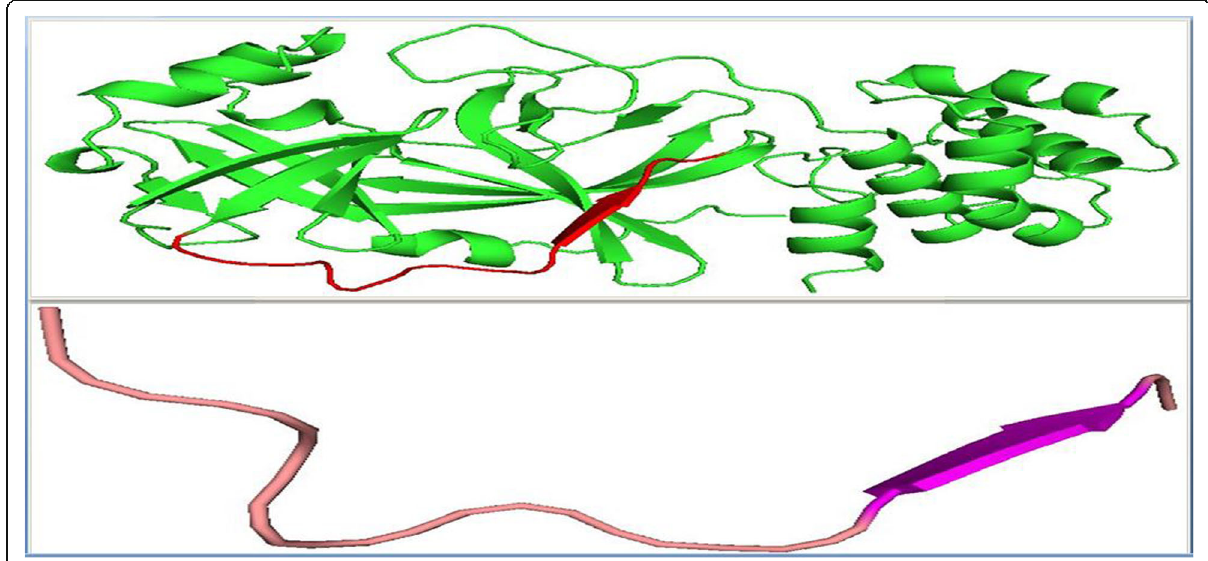
Fig. 5 The first column is a 3D view of the 2019-nCoV main proteinase with highlighted antigenic region (red) while the second column shows the loop dominated secondary structure of the antigenic